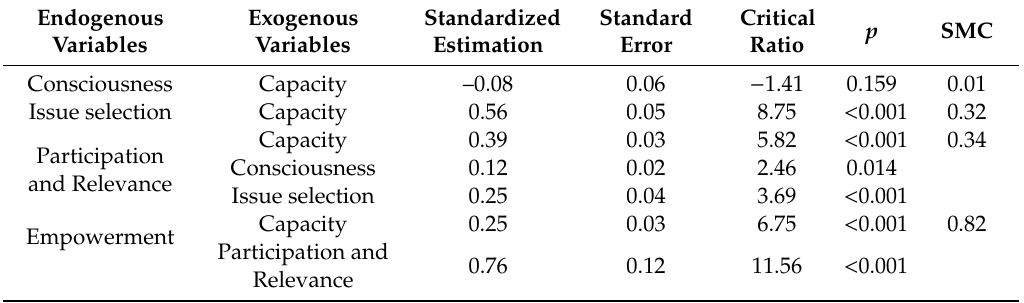
Table 3. Standardized path coe ffi cients of the modified model of the community organizational model of those working at small businesses in Korea.